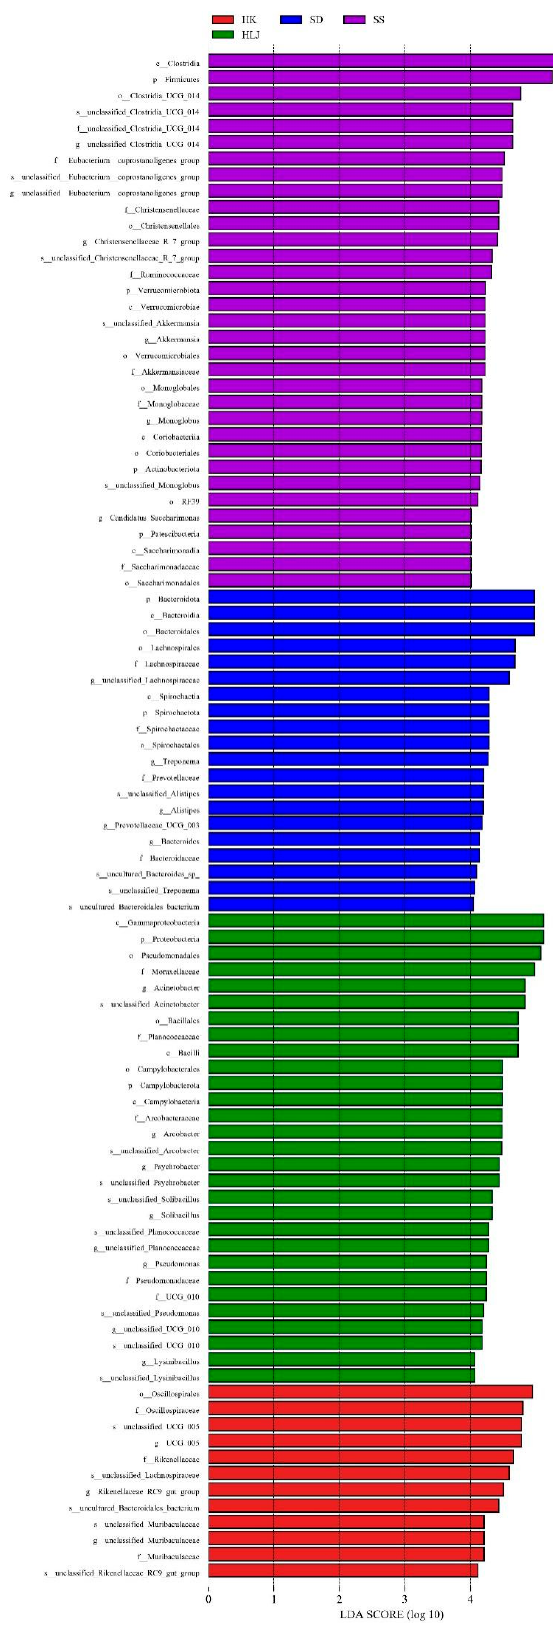
Figure 3. LEfSe analysis shows 94 biomarkers of fecal microbiota from four sampled loca- tions.Histogram of LDA scores represent the differences in the proportions of fecal microbiota. Taxa meeting an LDA significant threshold of >4 are